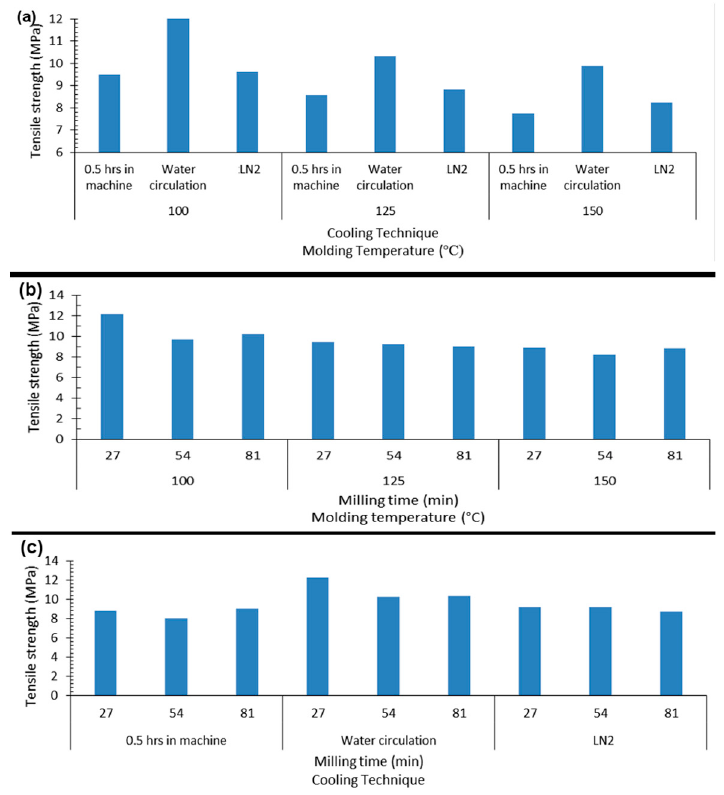
Figure 2. Effect of processing parameters on tensile strength of compression molded PCL/PEO films: ( a ) cooling technique and molding temperature (°C), ( b ) milling time (min) and molding temperature (°C), ( c ) milling time (min) and cooling technique .